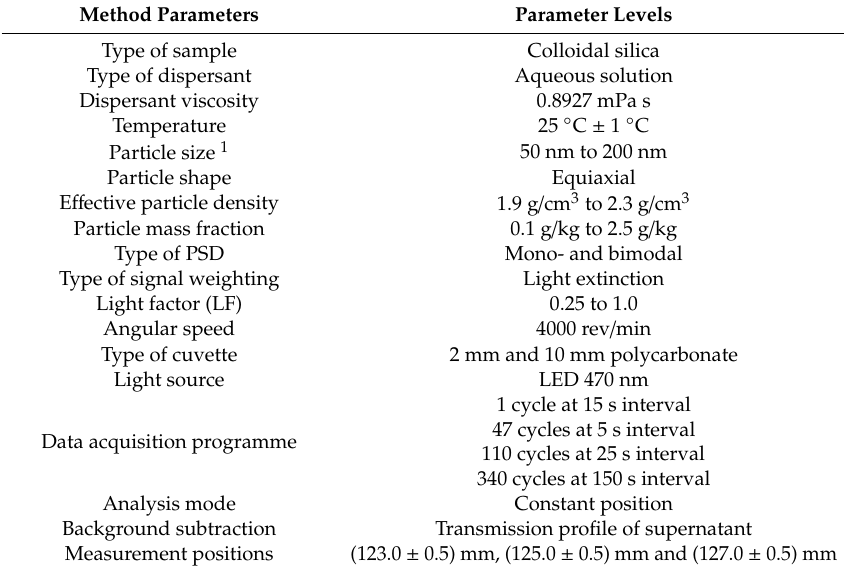
Table 3. Cuvette-CLS settings and conditions applied for method